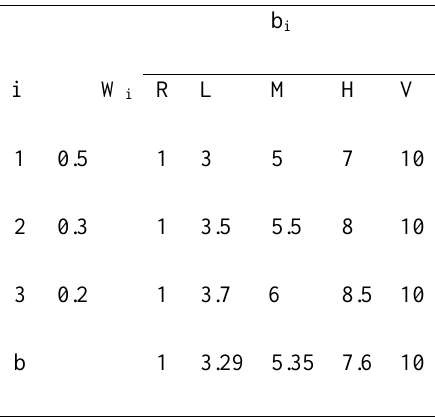
Table 2. Value of Membership